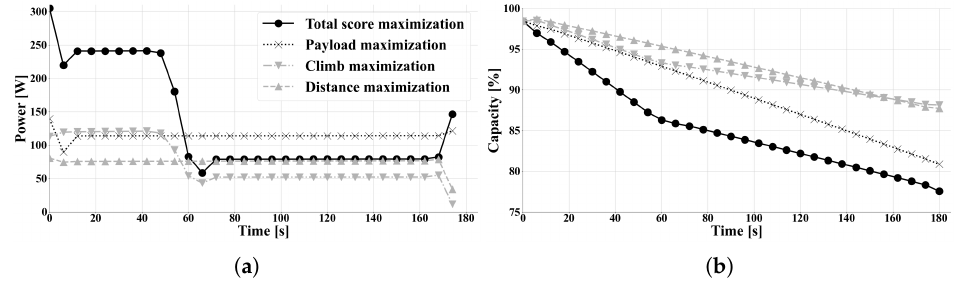
Figure 22. Power and battery consumption: ( a ) Power; ( b ) Battery capacity.